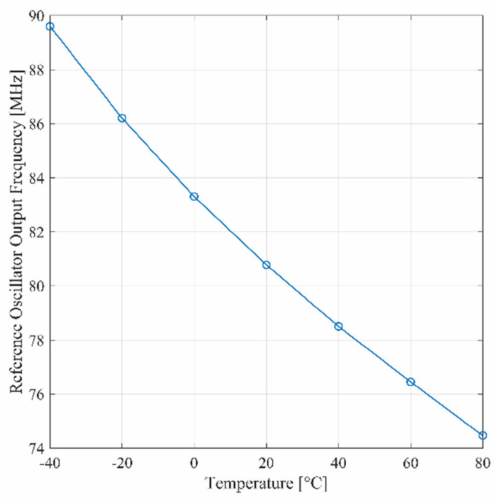
Figure 6. Simulated signal frequency versus temperature for ∆ C i = 1 fF of reference ring oscillator (RO) and Schmitt trigger.